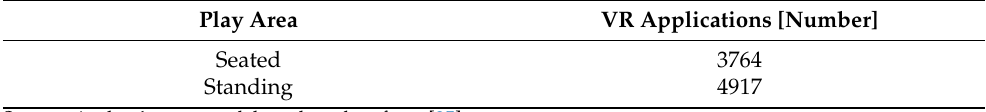
Table 4. The number of VR applications based on the play area [state on 6 July 2022].